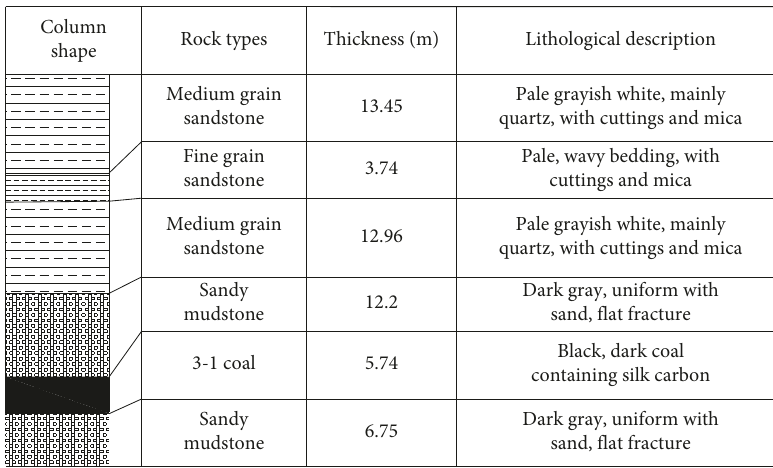
Figure 1: Integrated strata histogram. Table 1: #311103 working face strong pressure phenomena statistical table.